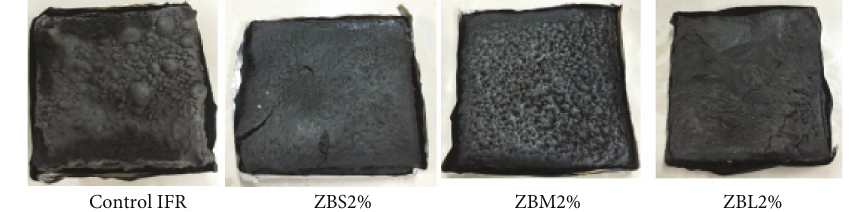
Figure 18: Digital photos of residual char of IFR with ZB in di ff erent particle sizes.